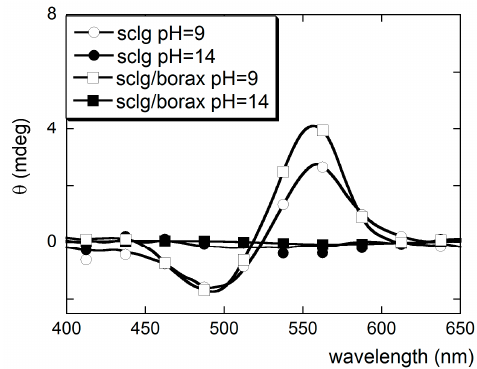
Figure 6. Circular dichroism (CD) spectra of CR–Sclg complex (circles) and CR–Sclg/borax (squares), at pH = 9 (empty symbols) and 14 (filled symbols) in water solution.